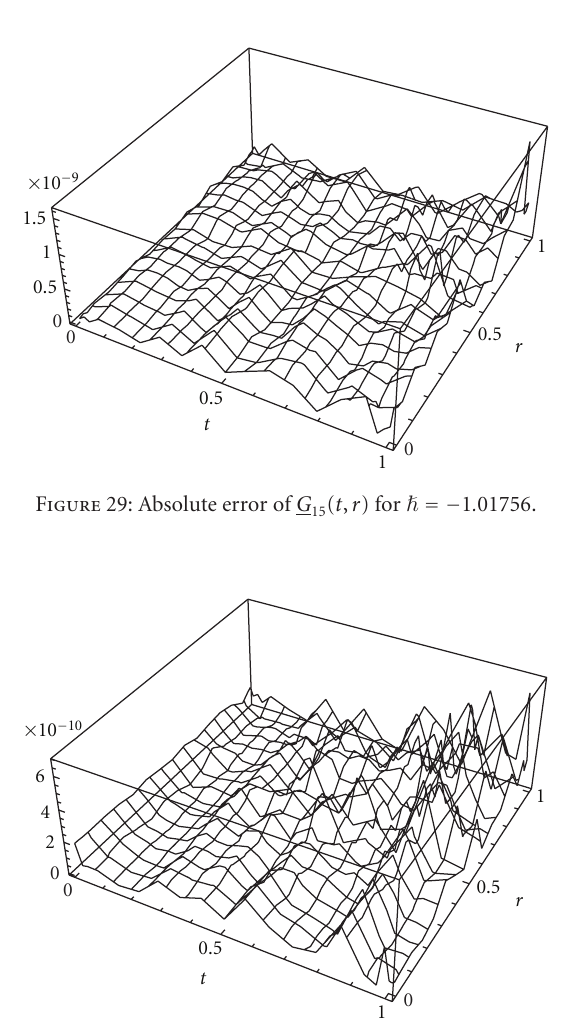
Figure 30: Absolute error of G 15 ( t , r ) for (cid:2) = − 0 .